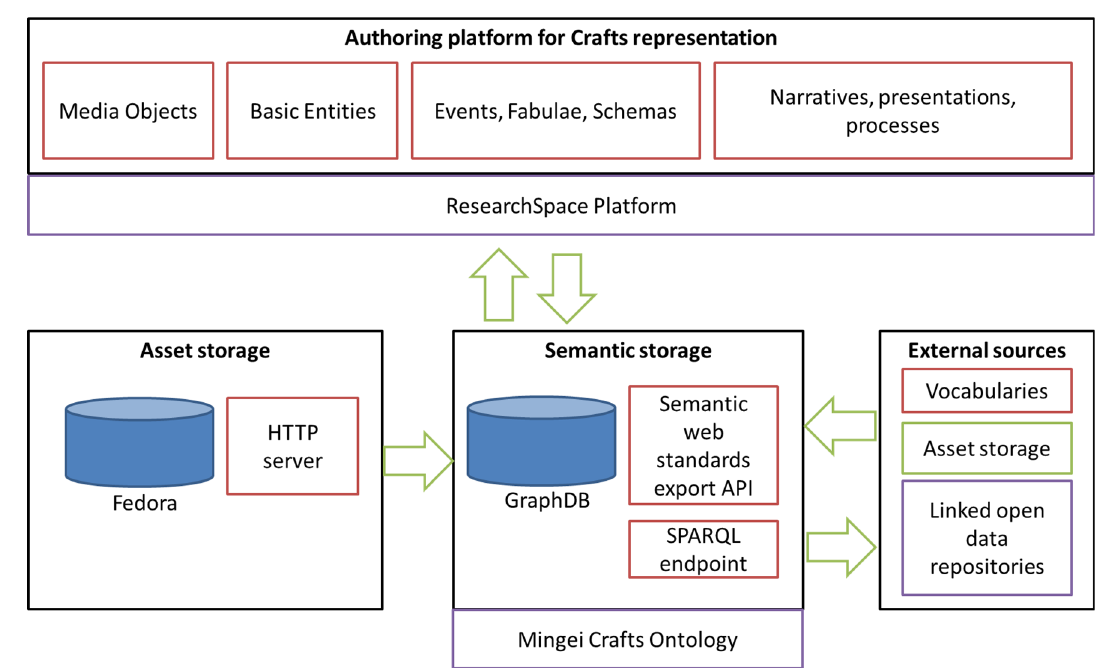
Figure 12. Conceptual architecture of the semantic platform.